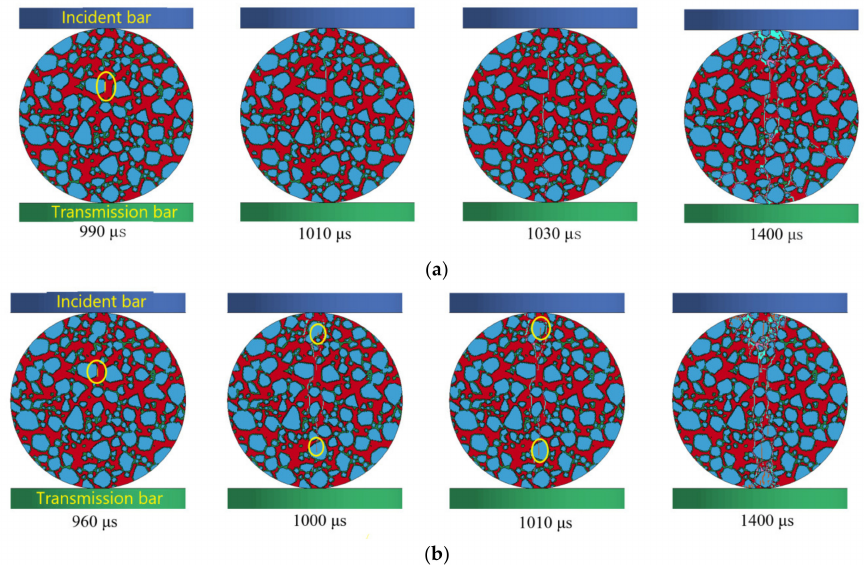
Figure 10. Failure process of concrete under different strain rates ( a ) 72.93 s − 1 ; ( b ) 186.51 s − 1